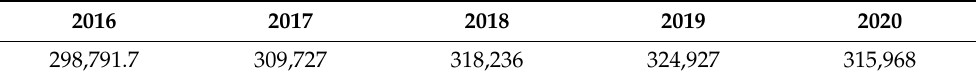
Table 1. Evolution of the gross electrical consumption in Mexico (GWh).